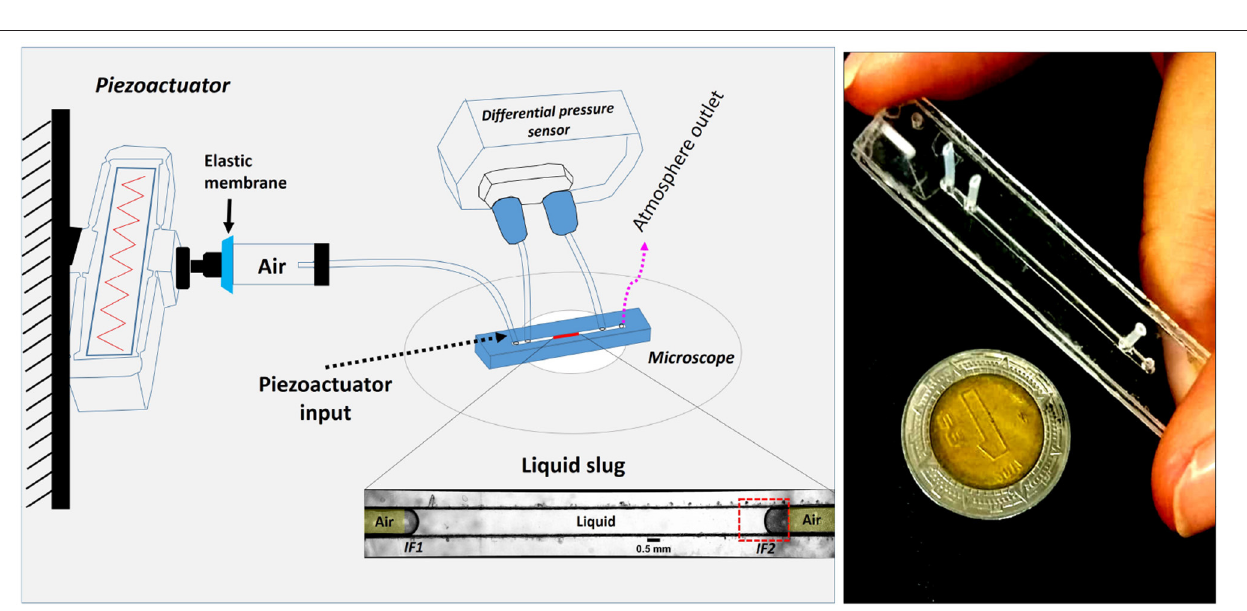
FIGURE 1 | Experimental setup. The displacement of a liquid slug within the microchannel is driven by the periodical movement of the piezoelectric actuator compressing the air trapped between the elastic membrane and the left side of the fluid slug IF1 . The position of one of the air-liquid interfaces, IF2 , is visualized and recorded by means of an inverted microscope and a high-speed